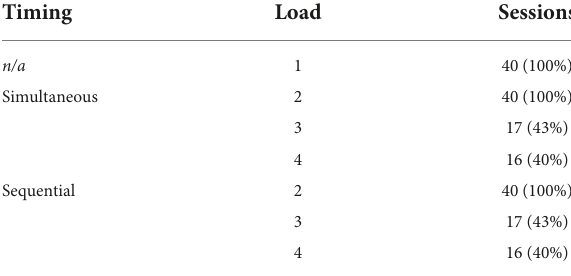
TABLE 1 Number of sessions in which Monkey F performed each trial